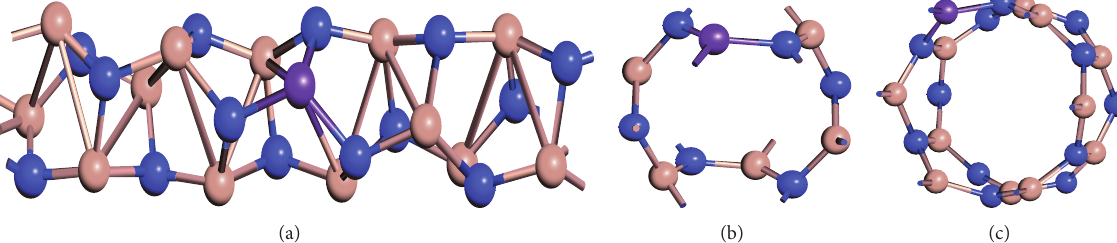
Figure 1: Mn doped GaN nanotubes of different tube indices: (a) chiral (2, 1), (b) armchair (3, 3), and (c) zigzag (6, 0). Blue, brown, and purple colors correspond to nitrogen gallium and manganese atoms, respectively.